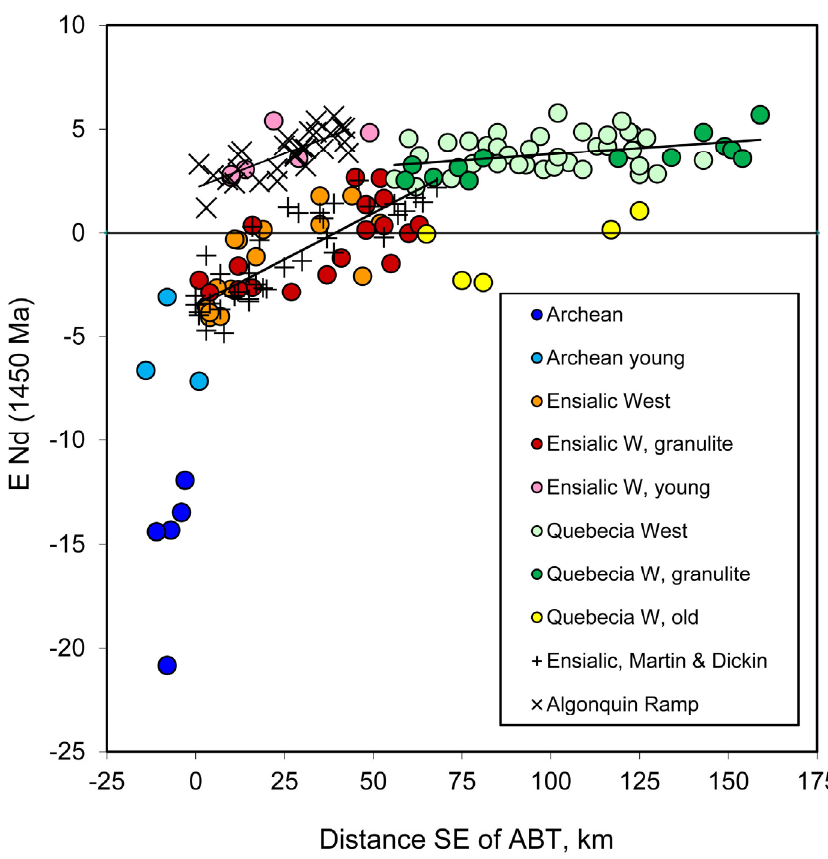
Figure 5. Plot of ε Nd values versus distance SE of the ABT, distinguishing between amphibolite facies and granulite facies